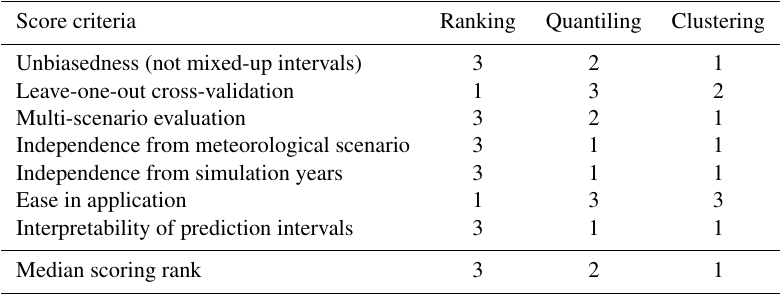
Table 4. Synthesis of scoring ranks attributed to the three methods for selecting representative parameter sets (based on quantitative metrics). The ranks are attributed descending from the best (1) to the worst (3) behaviour. The median scoring rank (last line) corresponds to the median over all criteria. Score criteria Ranking Quantiling Clustering Unbiasedness (not mixed-up